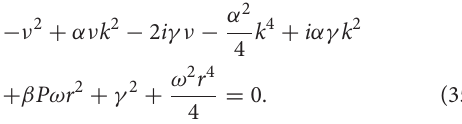
1.3, δ 0 ( t ) exp(0.5 0.5cos t ) and α = = + 0.4cos t ) and α tan 2 (0.02 t ), and (D) + =